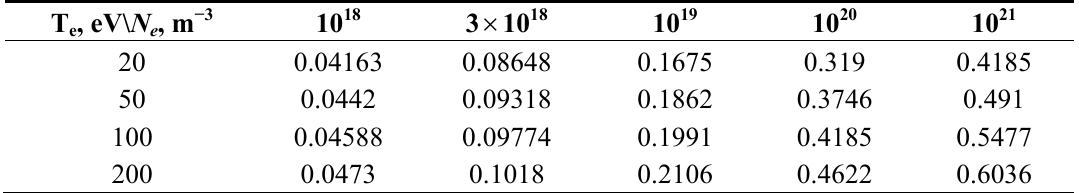
, N ) for the hydrogen atomic e e